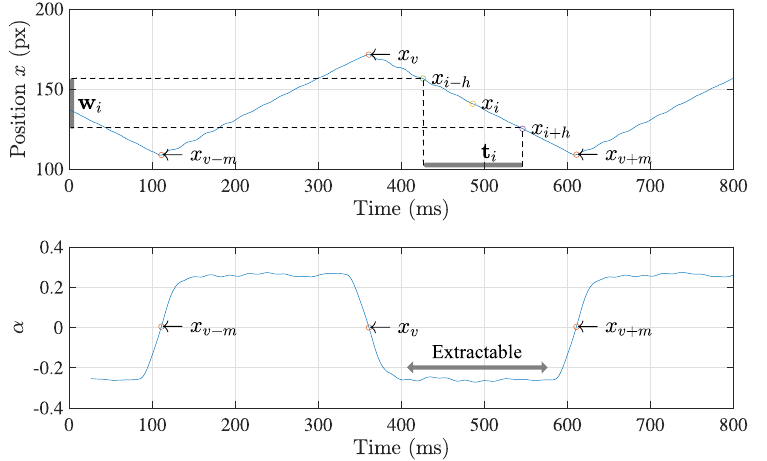
Figure 5. Extraction of a linear section from the trajectory. The linear section of the trajectory is extracted with the suggested method based on the linear regression. The slope α of the regression line can be a criterion to extract the linear section from the noisy